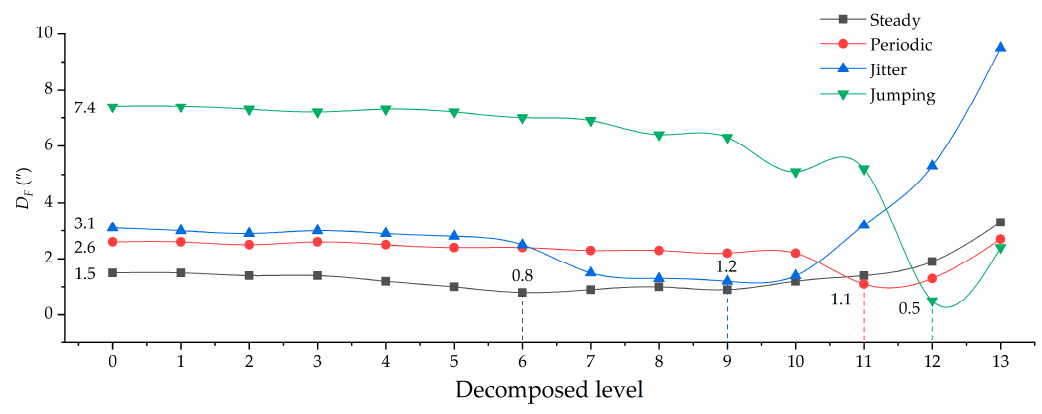
Figure 5. Comparison of H for different types of reconstructed signals under different decomposed levels.